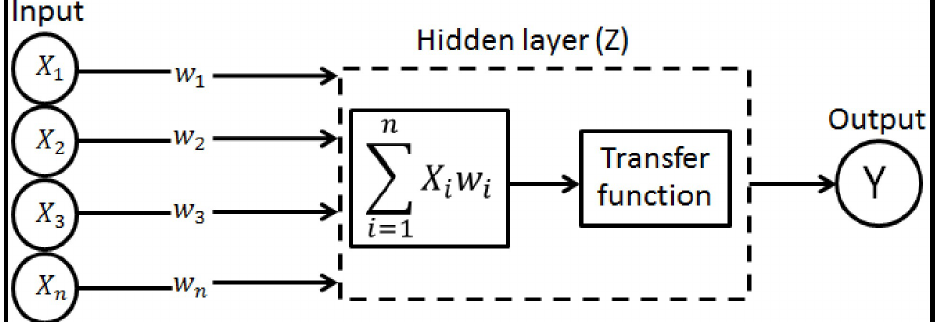
Figure 1. A typical structure of an ANN with three